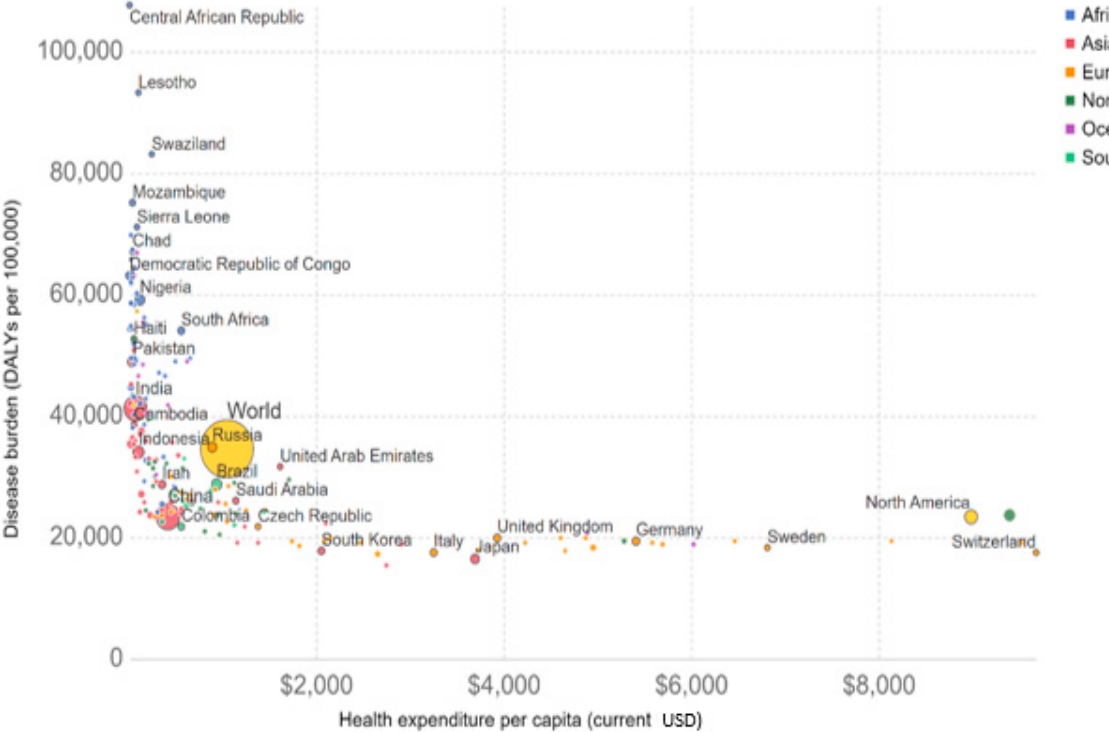
Figure 21. Relationship between the number of DALYs per 100,000 individuals vs. the health expenditure per capita in USD throughout the world in 2012. Information provided by M. Roser and H. Ritchie (2019) in “Causes of Death,” published online at OurWorldInData [87].